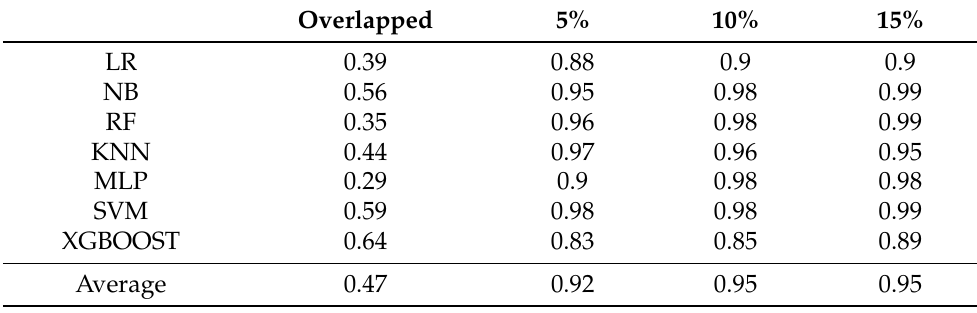
Table 7. Performance comparison of classifiers in terms of Matthews correlation coefficient.